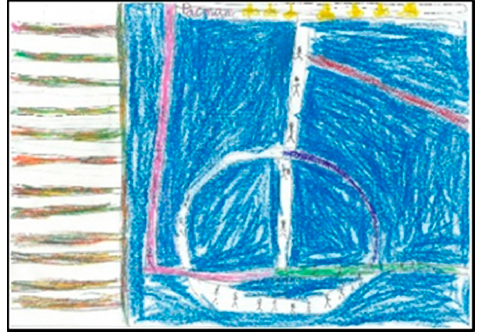
Figure 6. Represented space. Lucía. 1°B.